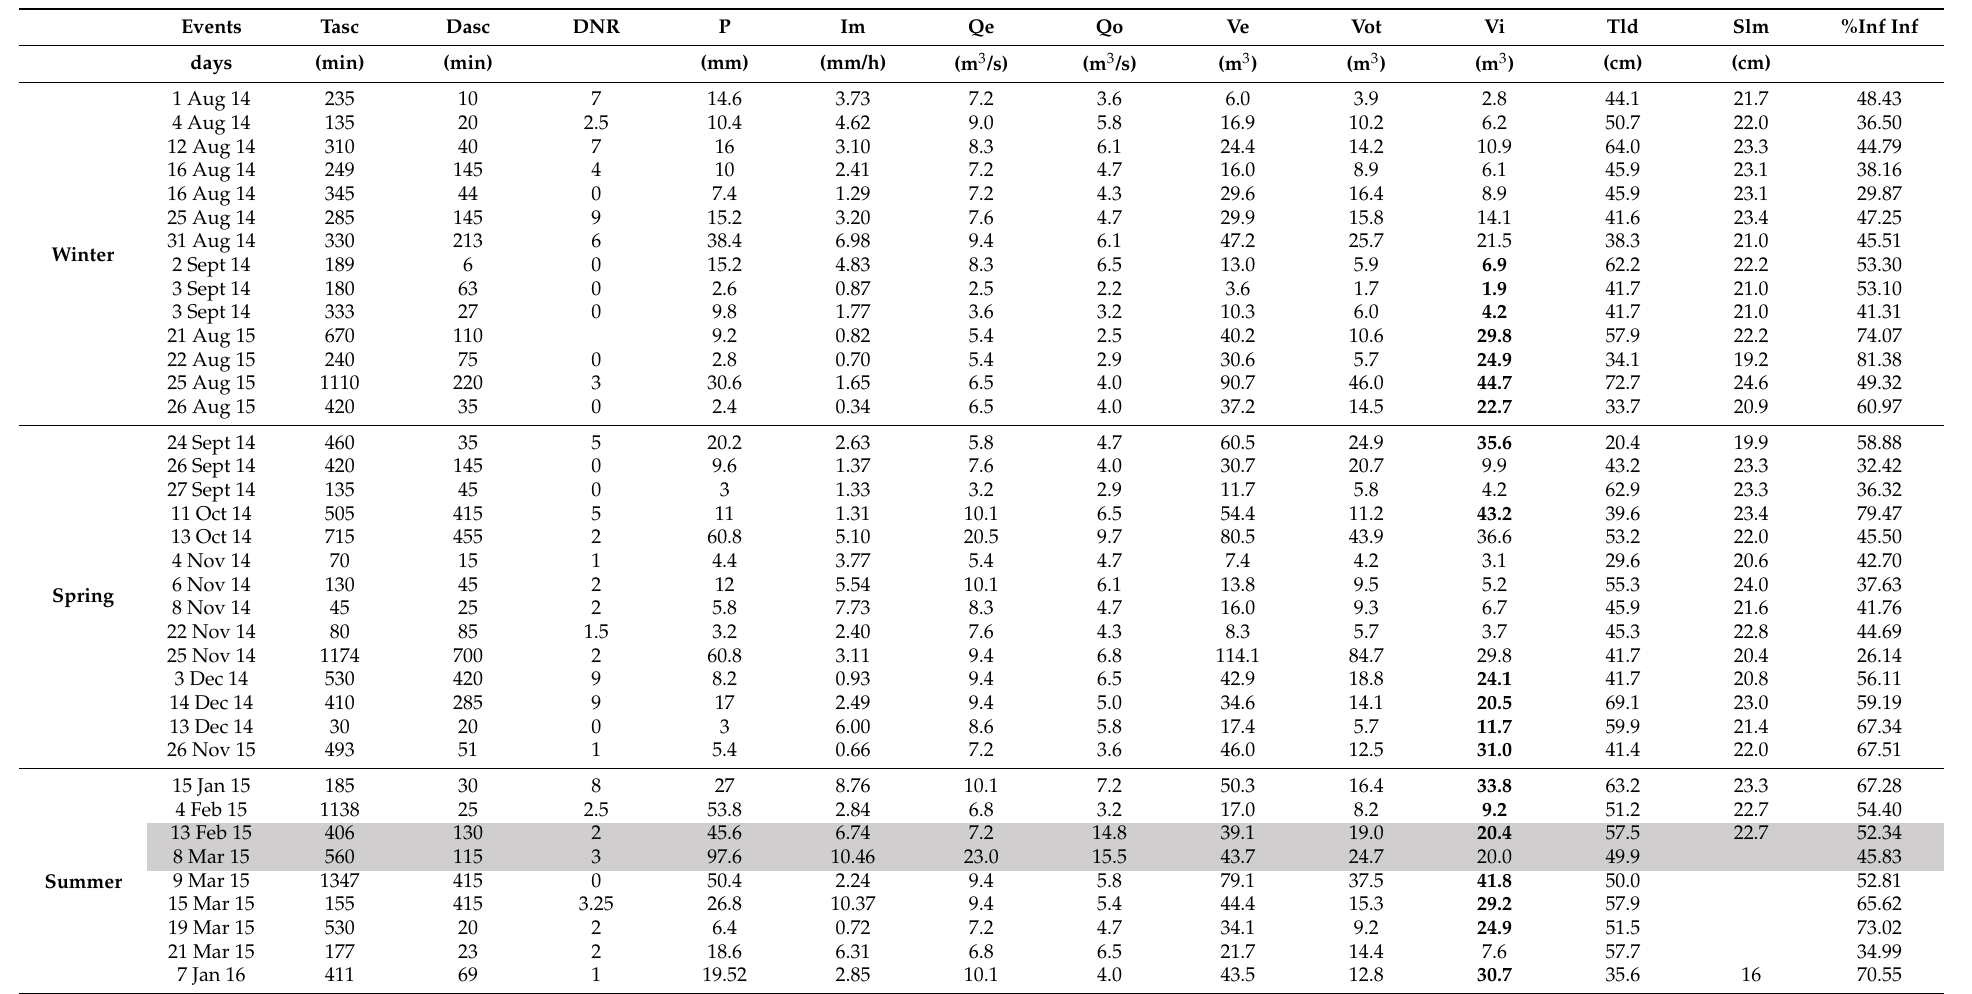
Table 1. Rainfall runoff data from the monitored events grouped by